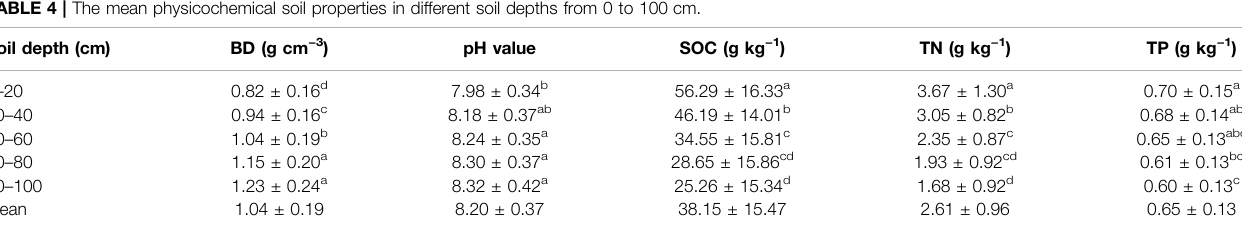
TABLE 4 | The mean physicochemical soil properties in different soil depths from 0 to 100 cm.